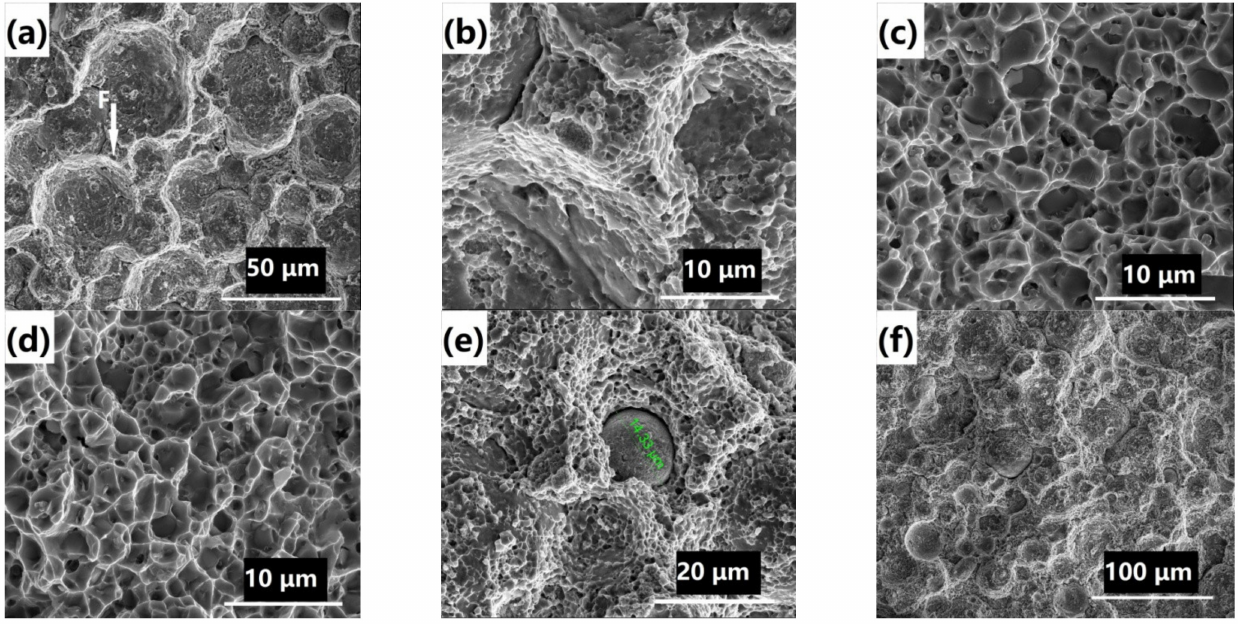
Figure 13. Fracture morphology of BSSs after HIP at ( a ) 900 ◦ C, ( b ) 900 ◦ C, ( c ) 1000 ◦ C, ( d ) 1100 ◦ C, ( e ) 1160 ◦ C, and ( f ) 1160 ◦ C of tensile